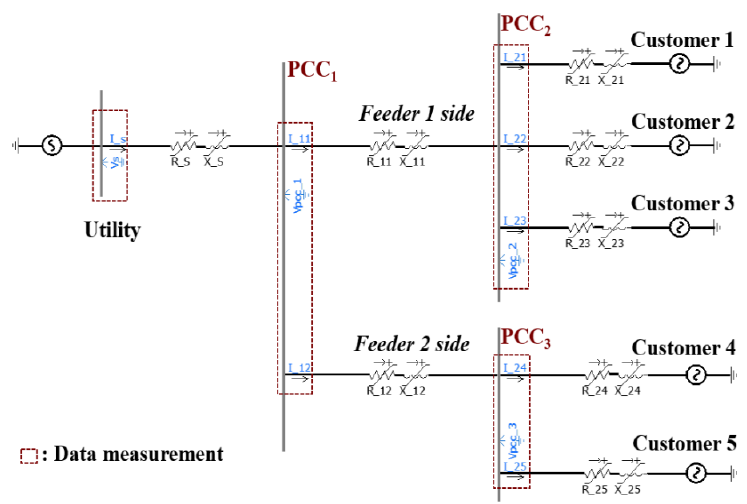
Figure 9. The PSCAD/EMTDC test system for harmonic contribution assessment.